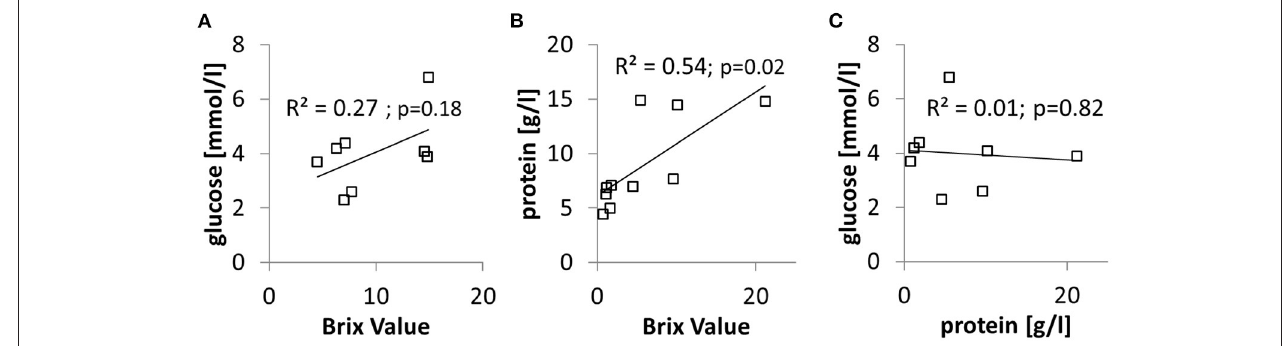
FIGURE 6 | Sample of serially aspirated gastric juice were tested in parallel for BV, glucose, and protein concentration. (A) Relationship between glucose concentration and BV. (B) Relationship between protein concentration and BV. (C) Relationship between glucose concentration and protein concentration.